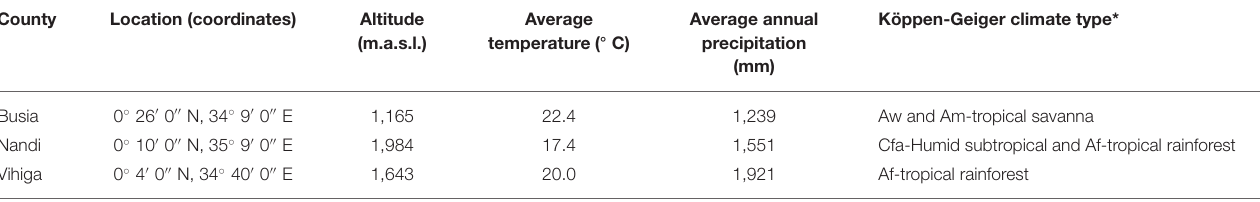
* Köppen-Geiger Rohli et al. (2015).